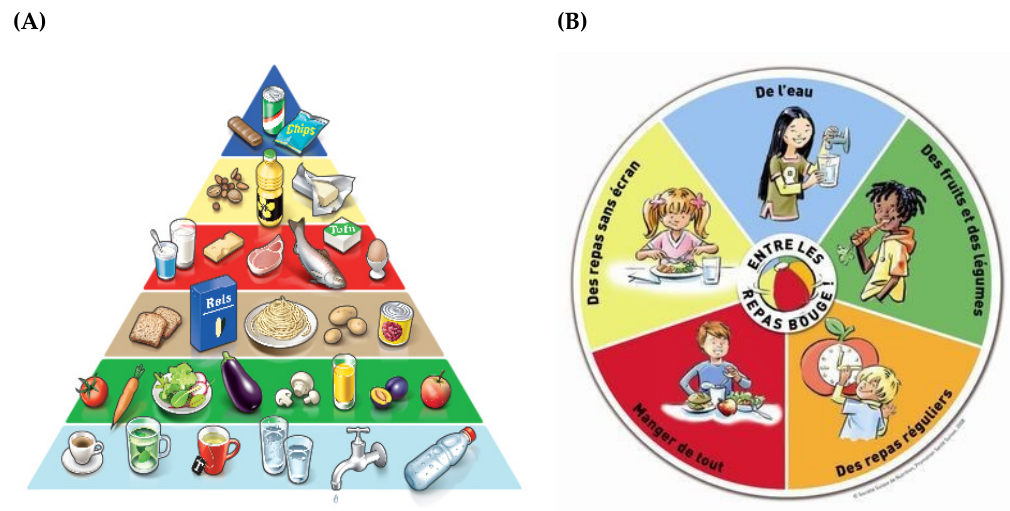
Figure 3. The Swiss food pyramid and children’s nutrition disk ( A ), the pyramid; ( B ), the plate for children.